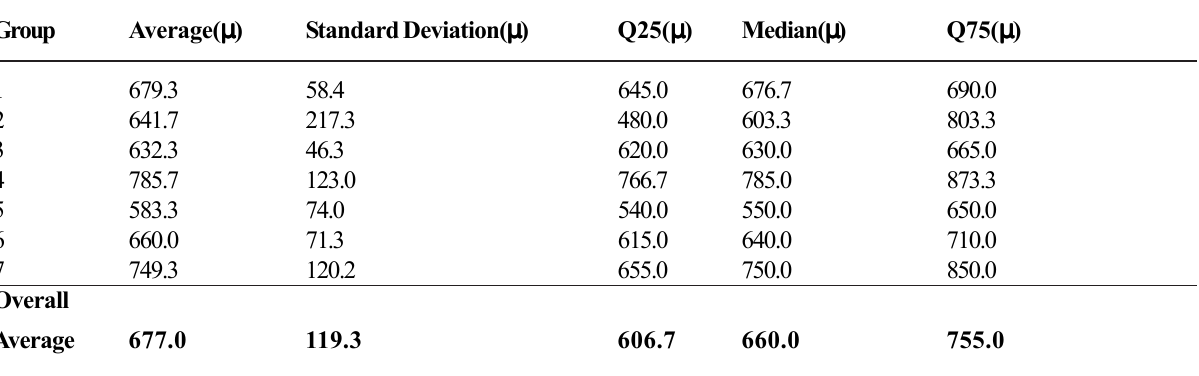
TABLE 2 — Measures of the lower edge thickness, with arithmetic average, standard deviation, Q25, median, Q75 of all groups, individually and globally.